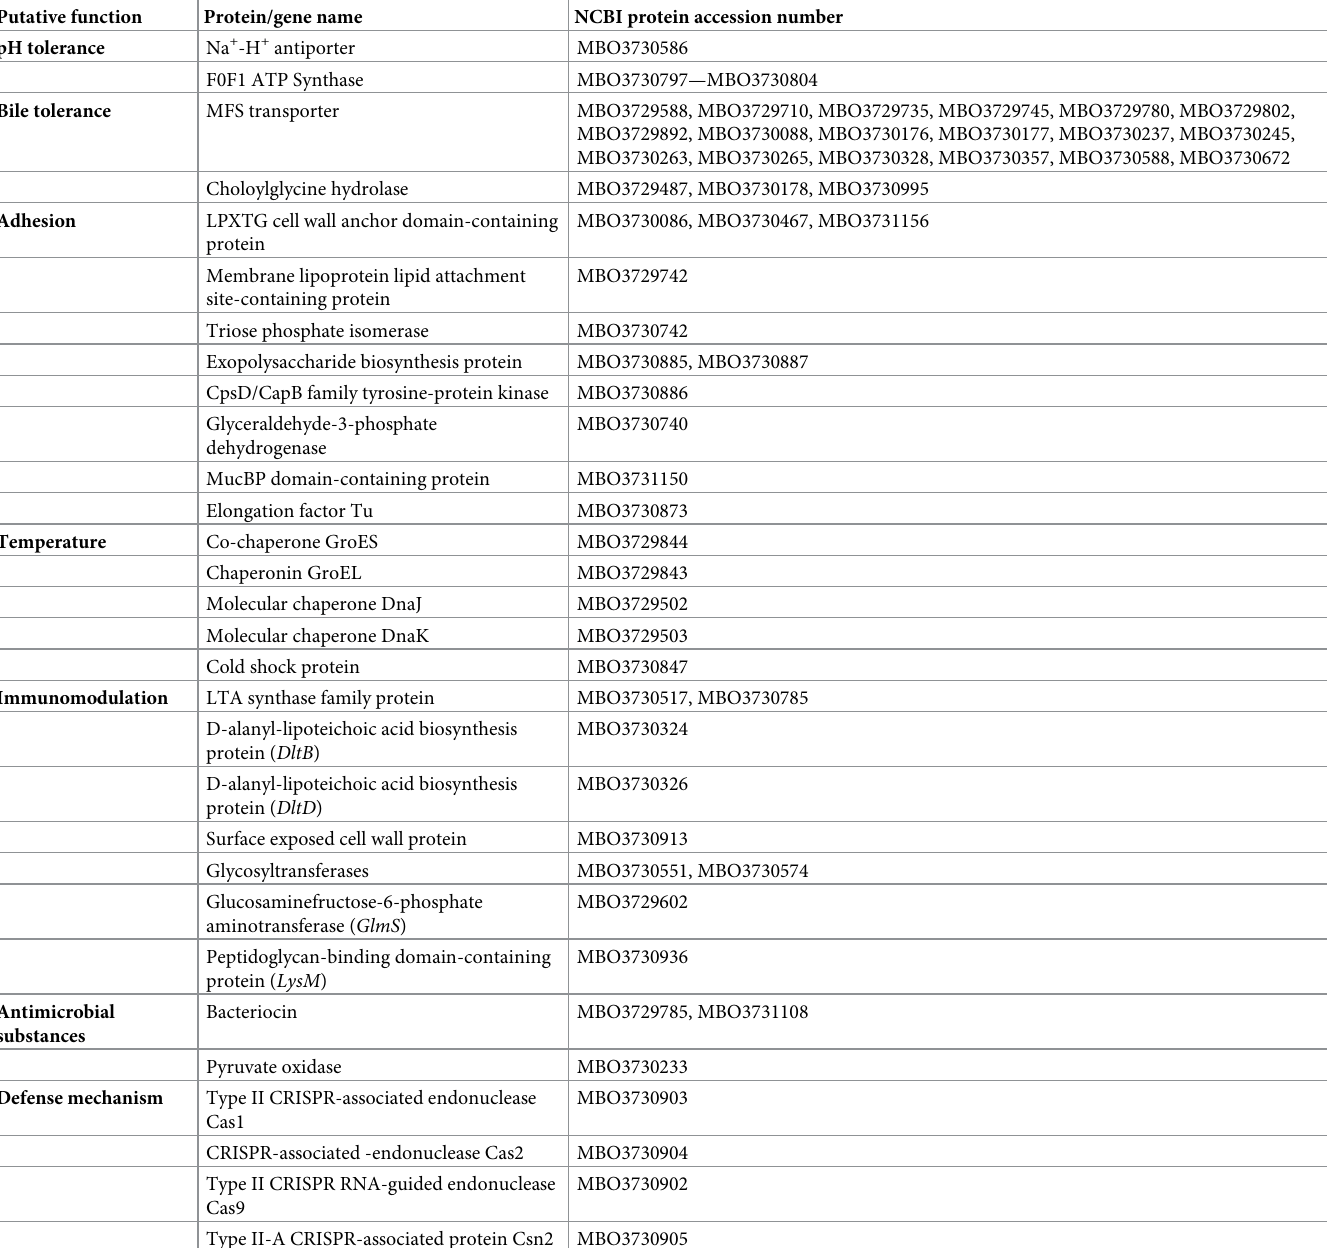
Table 4. Proteins involved in the potential probiotic properties of Lactobacillus paragasseri UBLG-36. Putative